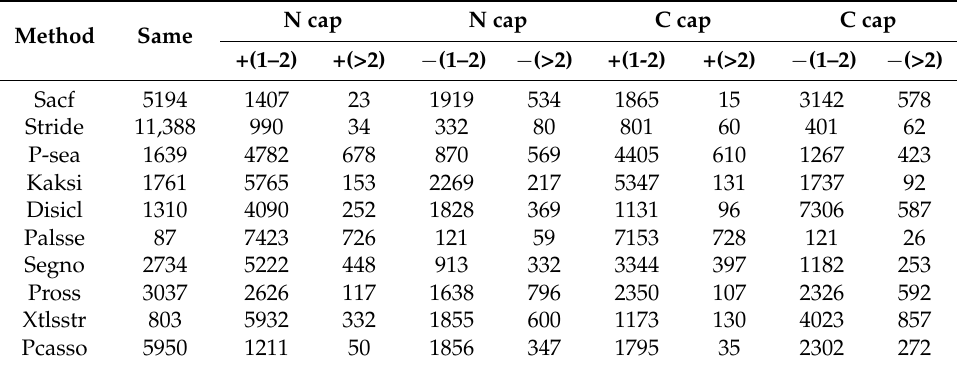
Table 4. Discrepancies between terminals in the helices assigned by DSSP and other methods.